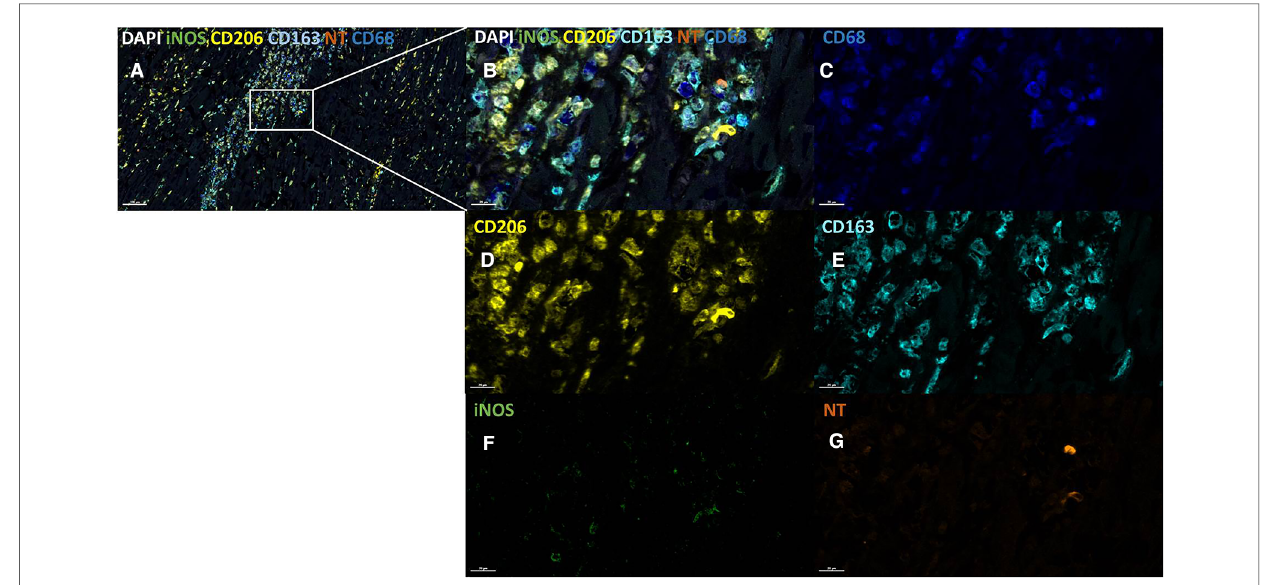
FIGURE 4 iNOS expression and NT production in different macrophage populations in infarcted regions. Infarcted tissue section, low magni fi cation ( A ) and high magni fi cation ( B ) stained using the following markers: CD68 (dark blue, C ), CD206 (yellow, D ), CD163 (light blue, E ), iNOS (green, F ) and NT (orange, G ). iNOS is visible within the CD163+ and CD206+ macrophage. Cell counterstain was performed with DAPI (white). Scale bars are shown in the